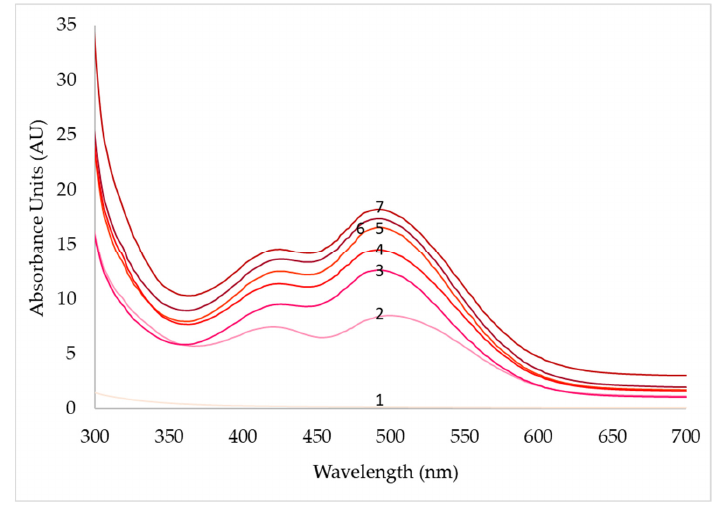
Figure 9. Absorbance scans of extracellular pigments (contained in the liquid broth) by spectrophotometry produced from days 1–7 for the culture of T. albobiverticillius 30548 at 24 °C, pH 5, with pO 2 at 90%. Colored spectra indicates the production of pigments with respect to hues from day 1 to 7. Table 3. Maximum absorption of the extracellular pigments produced under different conditions using PDB culture media in a 2 L bioreactor measured at the wavelengths of 430, 470 and 500nm indicating the regions for yellow, orange and red pigments, respectively.